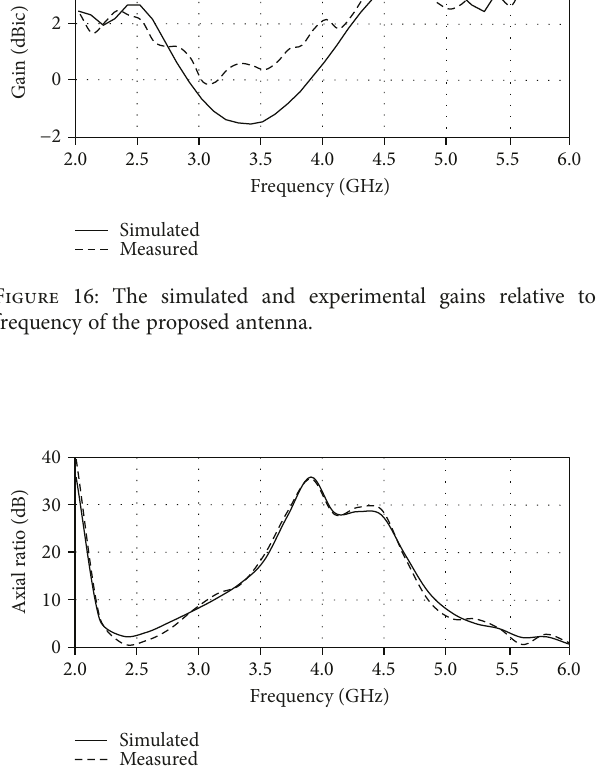
Figure 17: The simulated and experimental axial ratios relative to 11 relative to frequency of the proposed